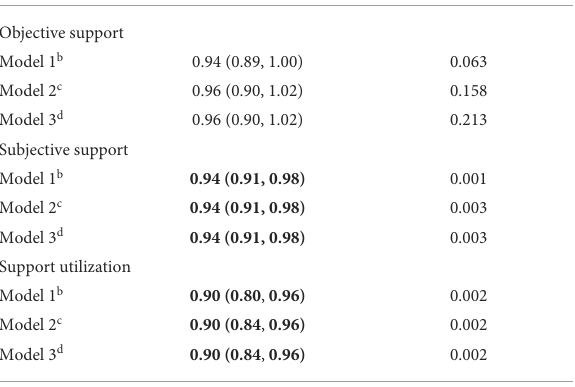
TABLE 6 The association of three domains of social support with cognitive impairment in logistic regression a . Domains OR of 1 unit increment P for 1 unit